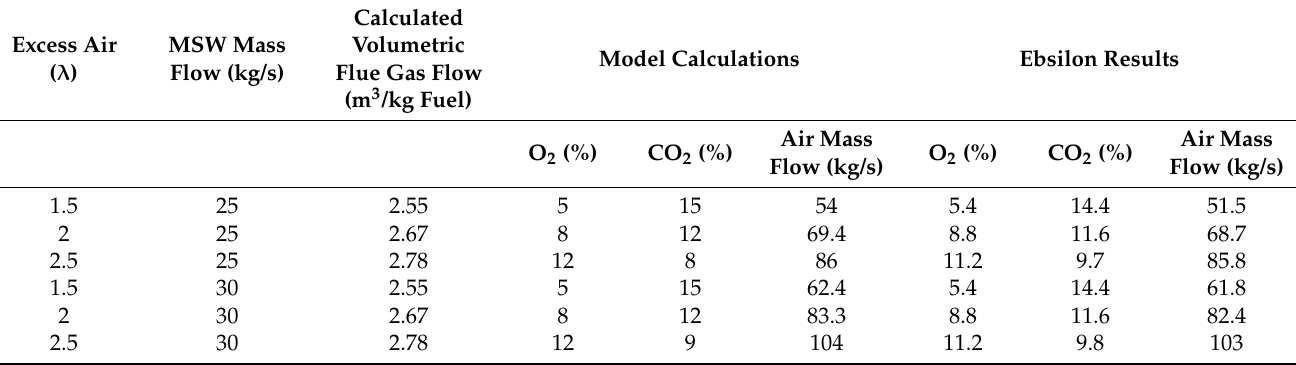
Figure 4. Results of CO 2 , O 2 , and air mass flow obtained from the calculation model. Table 10. Volumes of O 2 and CO 2 in flue gas and the air mass flow required in the furnace (verified using the model calculation and Ebsilon